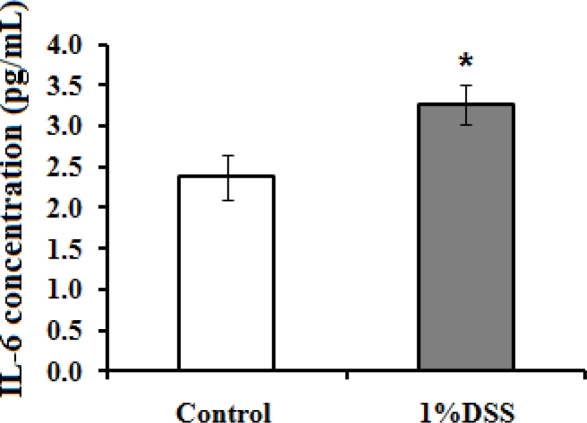
Secretion of IL-6 in cell culture medium by control (□) and 1% DSS-treated (
) Caco-2 cells. Supernatants were collected for each of control and DSS-treated cells at 2, 6, 8, 10, 24, 32, and 56 hours, and IL-6 levels were measured, and averaged. Results therefore represent the mean of 28 determinations ± SD, p = 0.00003.